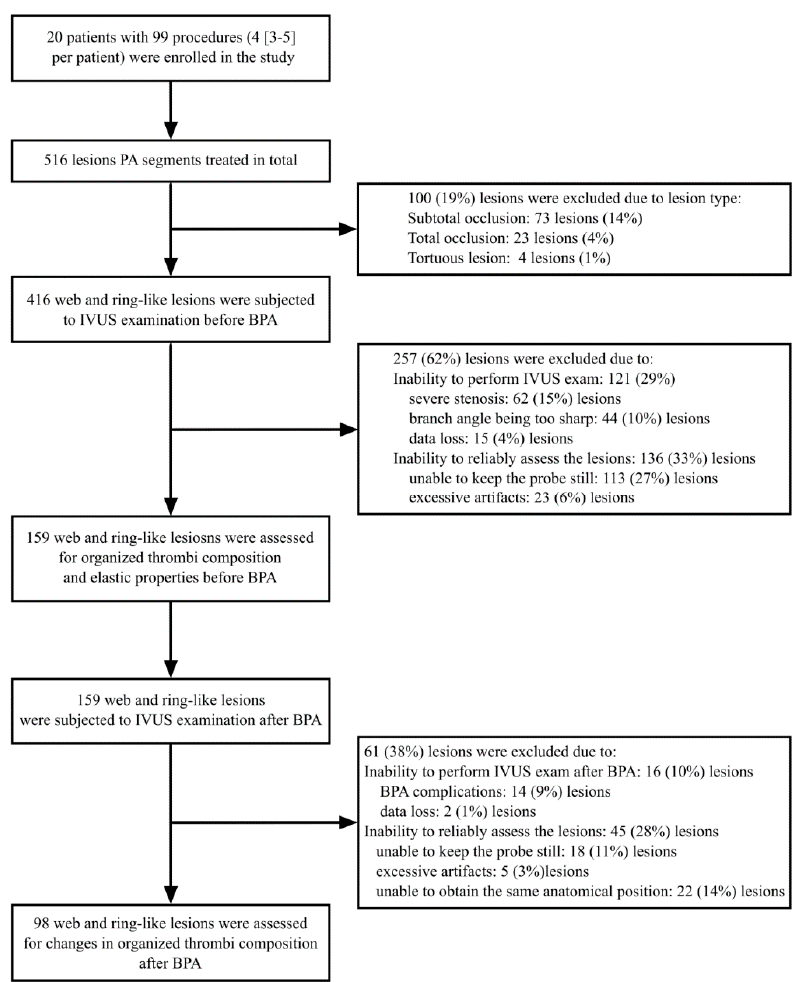
Figure 2. Flowchart presenting the selection of the stenosed pulmonary arterial segments. Figure2. Flowchartpresentingtheselectionofthestenosedpulmonaryarterialsegments. Abbreviations: BPA—balloon pulmonary angioplasty; IVUS—intravascular Abbreviations: BPA––balloon pulmonary angioplasty; IVUS––intravascular ultrasound.